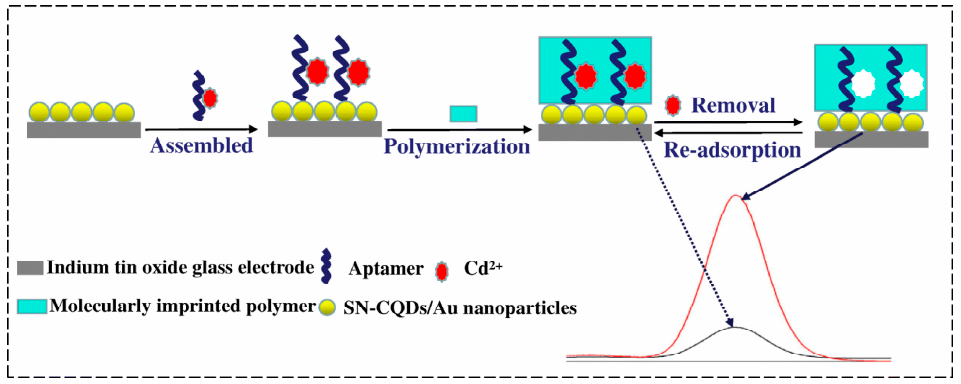
Figure 5. Fabrication of the fluorescence MIP–aptamer sensor for Cd 2+ detection. Reproduced with permission from [67]. Copyright Springer, 2019.